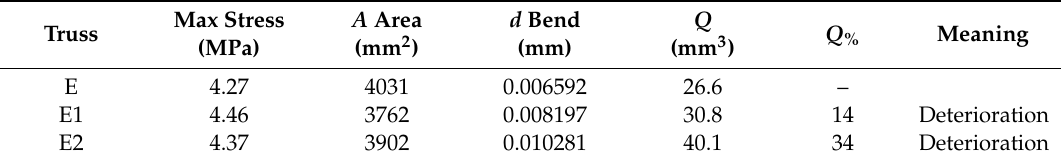
Figure 12. Determining the optimal support location. Table 2. Comparing the influence of the inner member support point in a Michell truss.